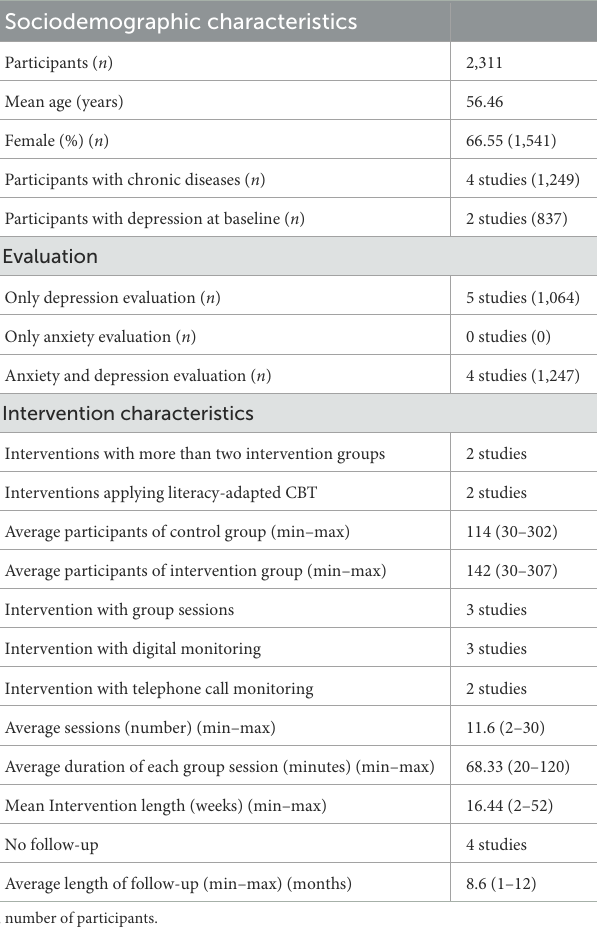
TABLE 1 Summary of